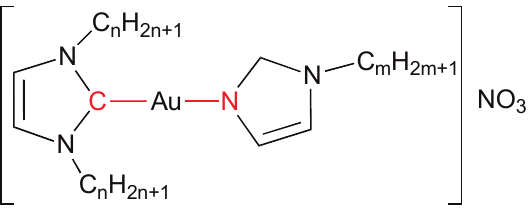
Figure 1. Gold mesogens containing N -heterocyclic carbene and imidazole. n = 12, 18; m = 1, 6, 12, 18. n = 16, m = 10, 12, 14, 16, 18.